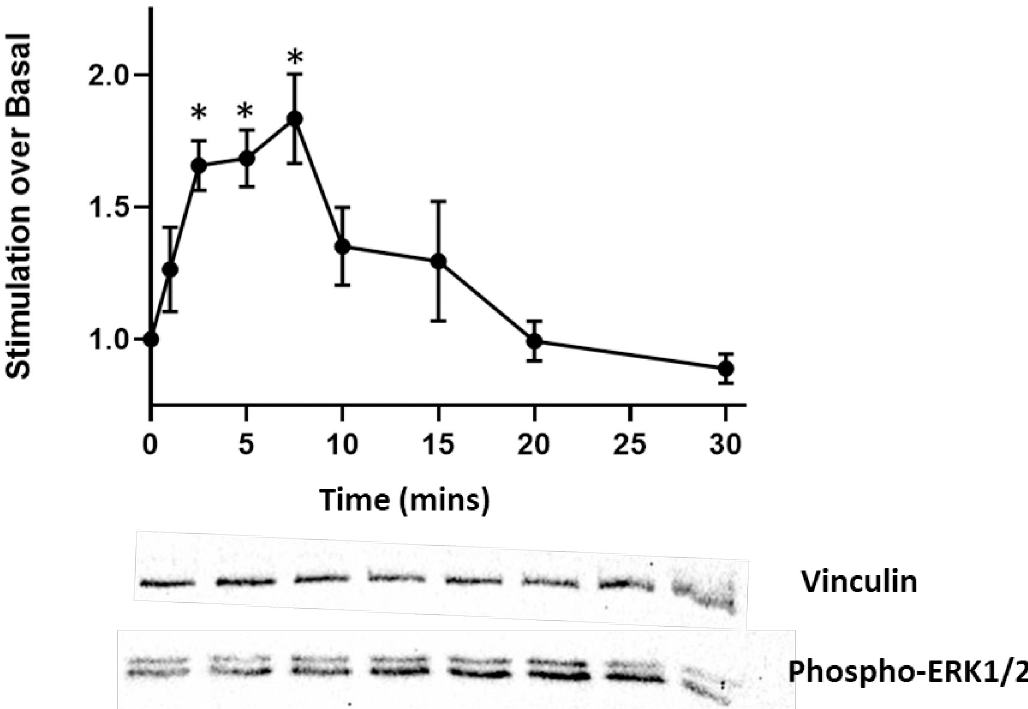
Fig 7. In HVSMC, NOP receptor induced activation of ERK1/2 following stimulation with 1 μ M N/OFQ. Representative Western blots shown below the graph. Analysis was undertaken on raw data using ANOVA and Bonferroni post hoc analysis, � statistically greater than raw basal activity (p <